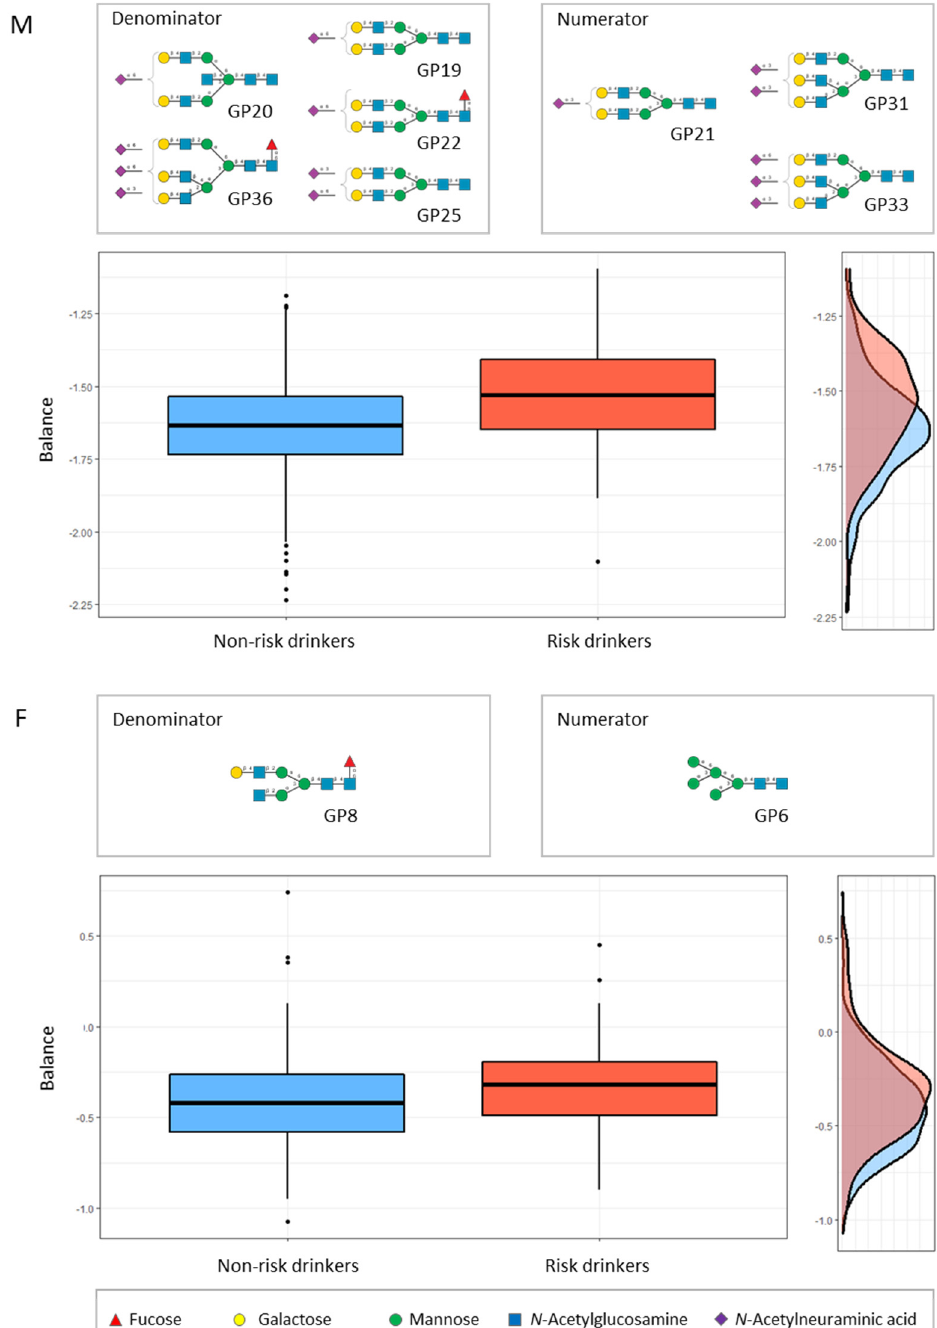
Figure 2. Description of the global N- glycan balance (or combination) for risk drinking using selbal algorithm [40]. The two groups of N -glycans that form the global balance (numerator and denominator) selected by selbal conditions are specified at the top of the plot. The box plot represents the distribution of the balance scores for risk drinkers and non-risk drinkers. The right part of the figure contains the density curve for each group. M (upper panel), men; F (lower panel),